Question: Reading the figure, is the described quantity rising or falling?
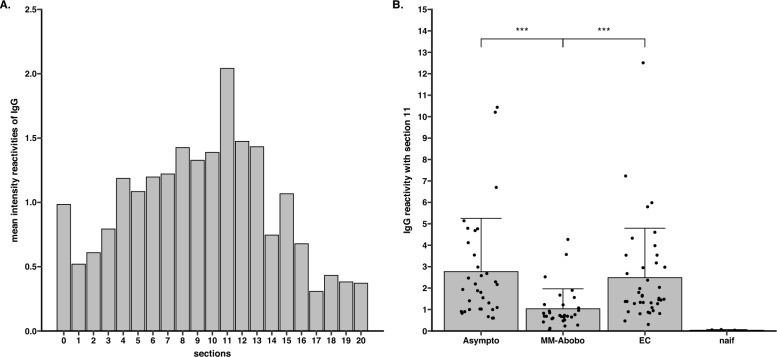
Answer: increasing